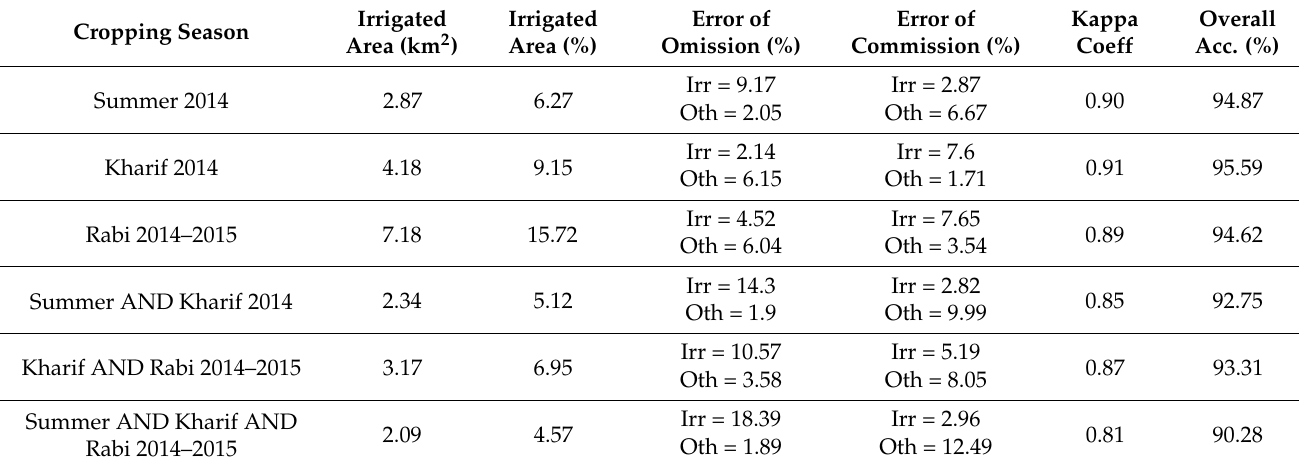
Figure 7. Temporal NDVI curves of irrigated ( A – C ) and non-irrigated ( D ) crops divided into four sub-sections. The sub-section ( A ) consists of turmeric and turmeric with onion, ( B ) consists of banana and sugarcane, ( C ) consists of beetroot, beans, and cabbage, and ( D ) consists of marigold, maize, and sunflower crops. Table 2. Classification accuracy of intensively irrigated cropland (Irr; intensive irrigation) and other croplands (Oth; rainfed, fallow, and partial irrigation in the absence of rainfall) for